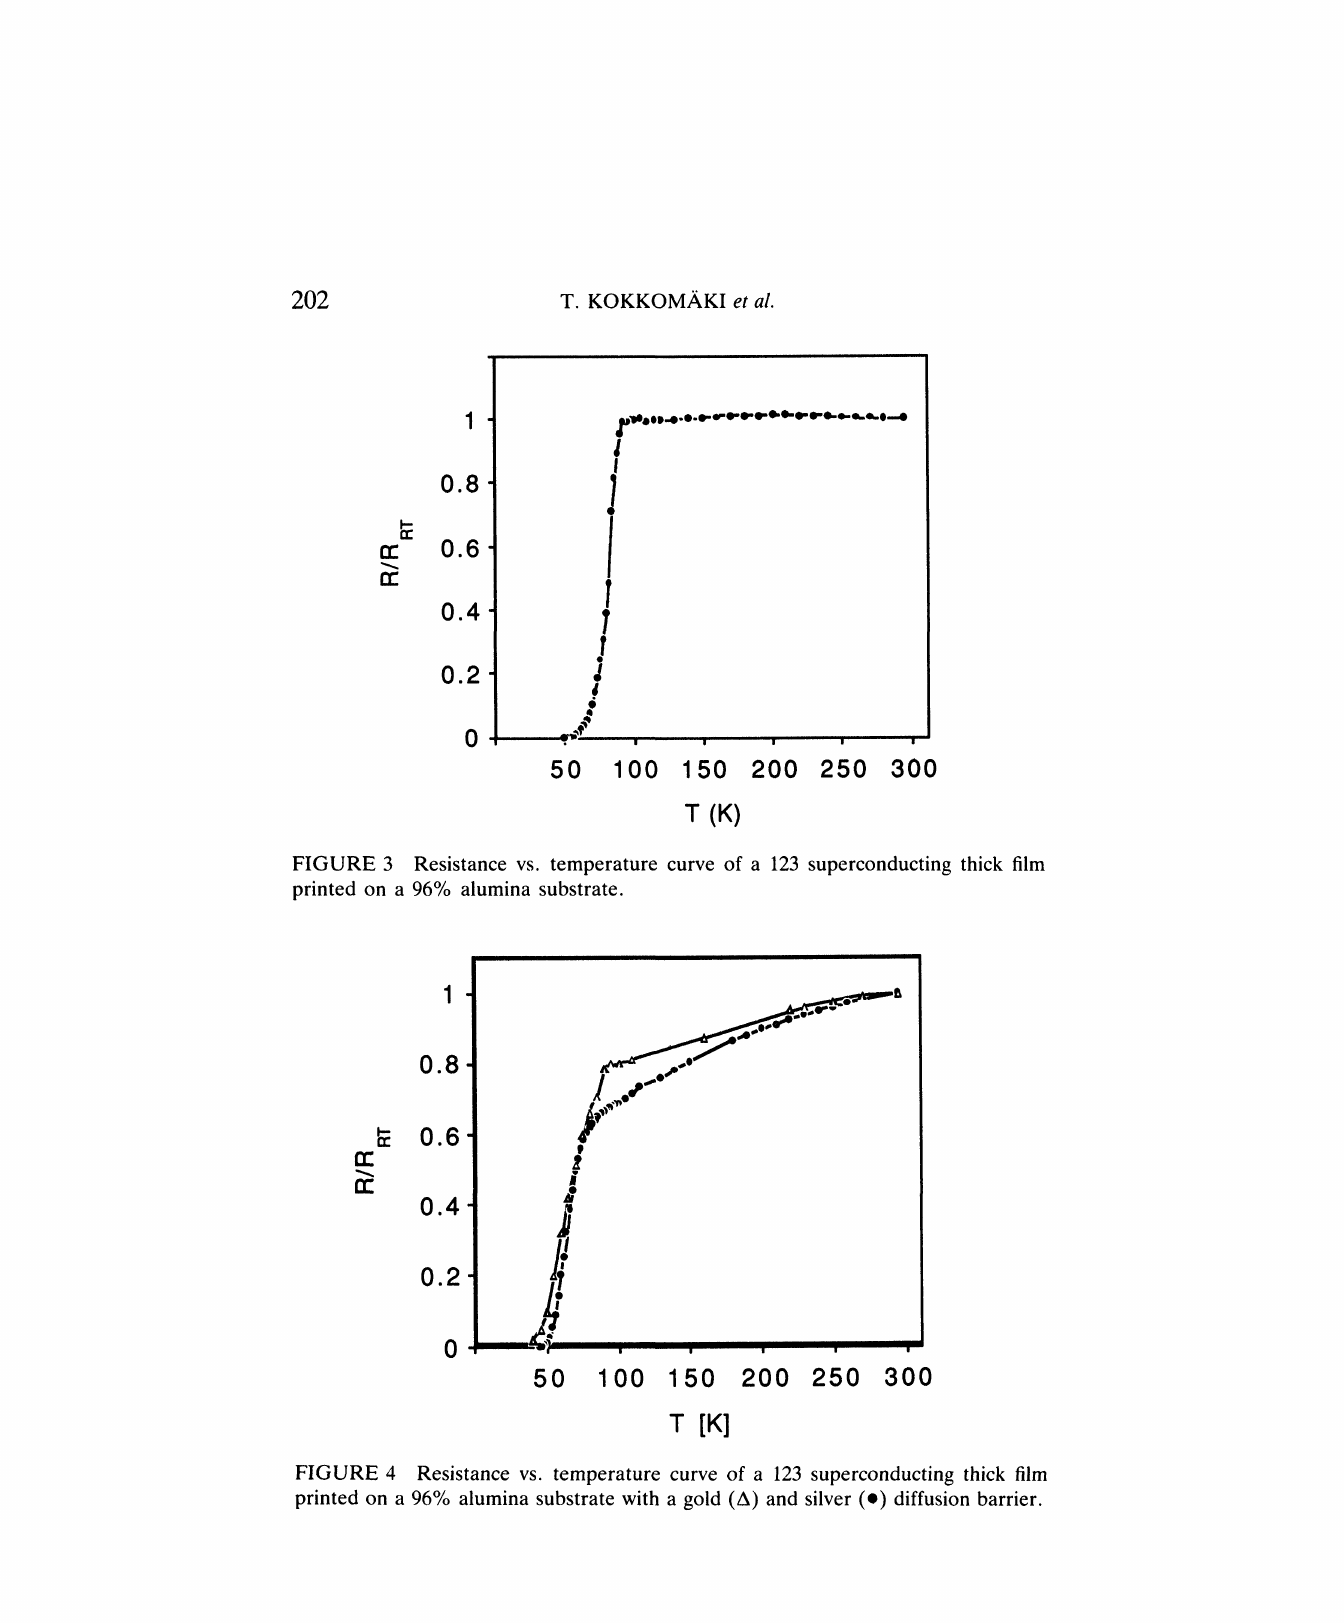
FIGURE 4 Resistance vs. temperature curve of a 123 superconducting thick film printed on a 96% alumina substrate with a gold (A) and silver (o) diffusion